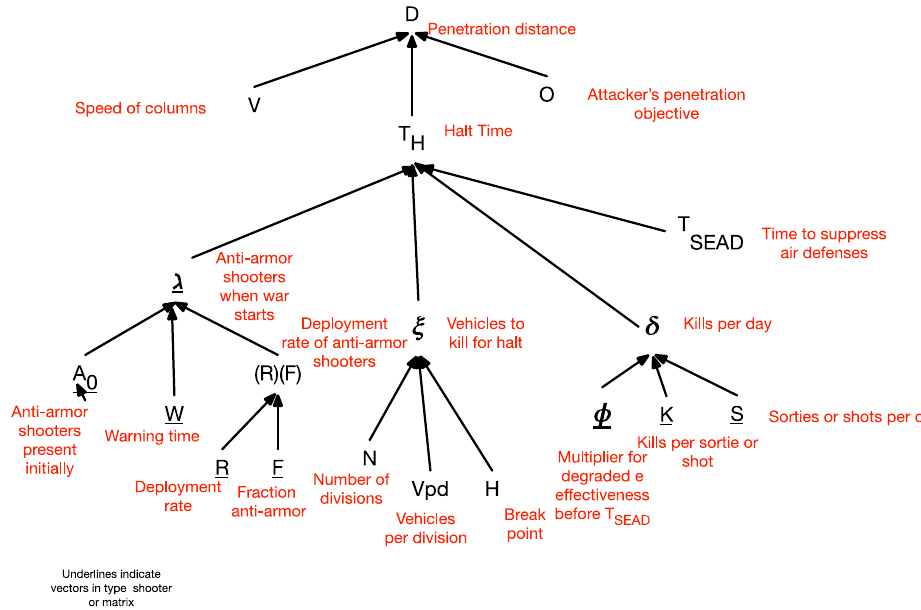
Figure 3. A simple graphic of the analytical halt problem